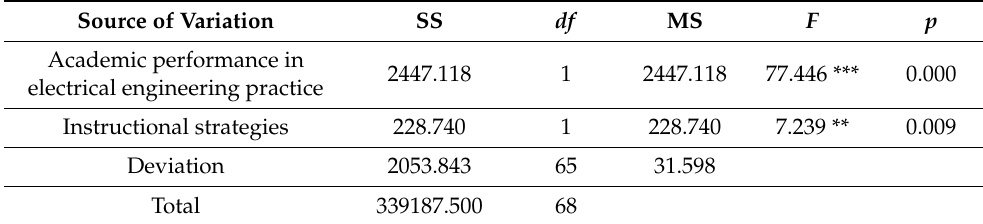
Table 10. Recapitulation sheet of analysis of covariance in basic electricity practical overall learning effectiveness.